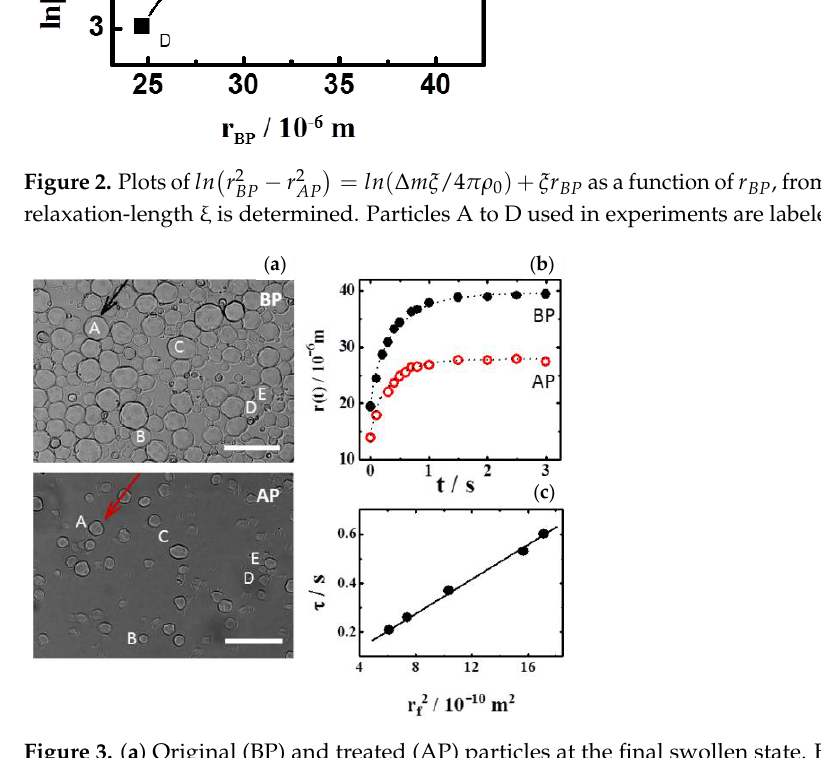
Figure 3. ( a ) Original (BP) and treated (AP) particles at the final swollen state. Bars correspond to 100 µ m. Capital letters label the set of particles selected to characterize the radial density distribution and particle swelling dynamics. ( b ) Particle A at 20 °C tracked from collapsed to swollen state. Dotted curves are solutions of the Fick-like diffusion equation, fitted to the experimental data. ( c ) Time scale of the processes, τ , obtained from the fittings.